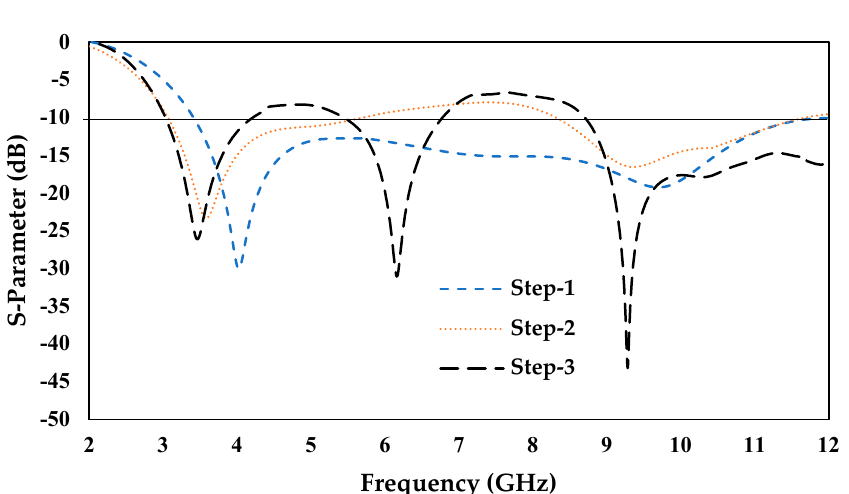
Figure 4. Step-by-Step design of proposed antenna.